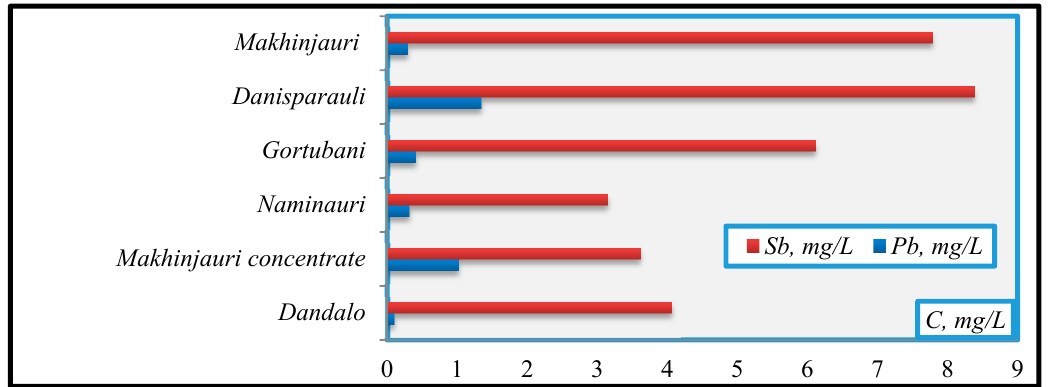
Figure 14. The content of Sb and Pb in the mineral waters.